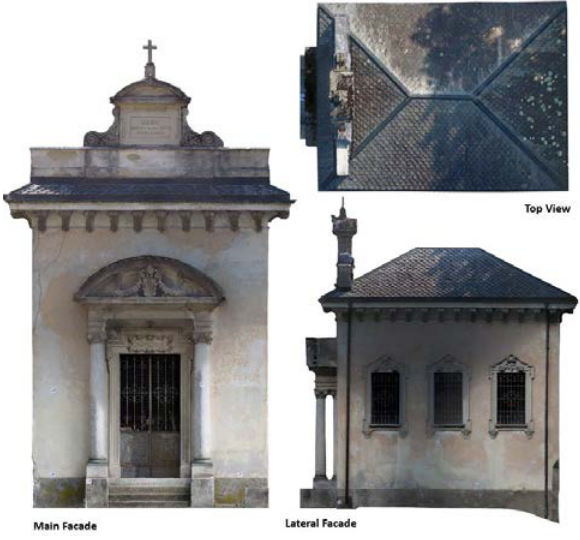
Figure 8: Orthoimages of Chapel three (architectural scale). The main outputs that can be extracted from the close-range photogrammetric acquisition are detailed (1:50 scale)